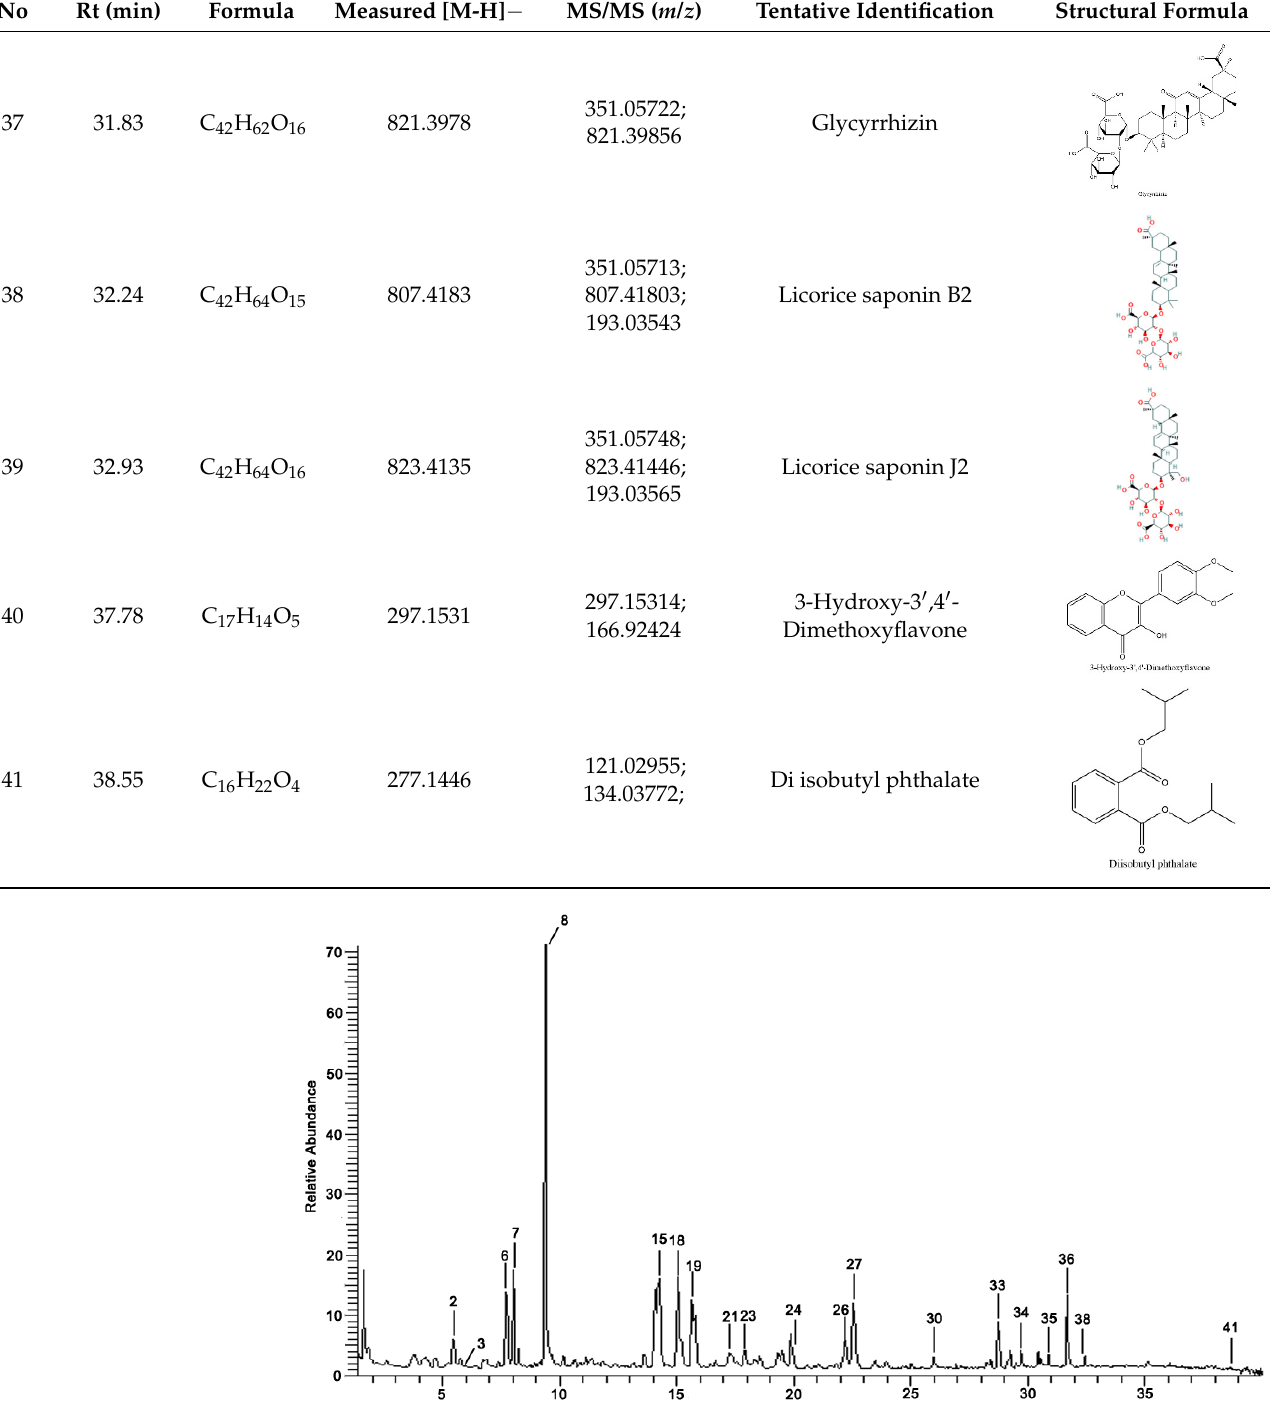
Figure 1. Chemical composition identification in GDK by LC-Orbitrap-ESI-MS. Table 1. Identified bioactive components of GDK with LC-Orbitrap-ESI-MS.